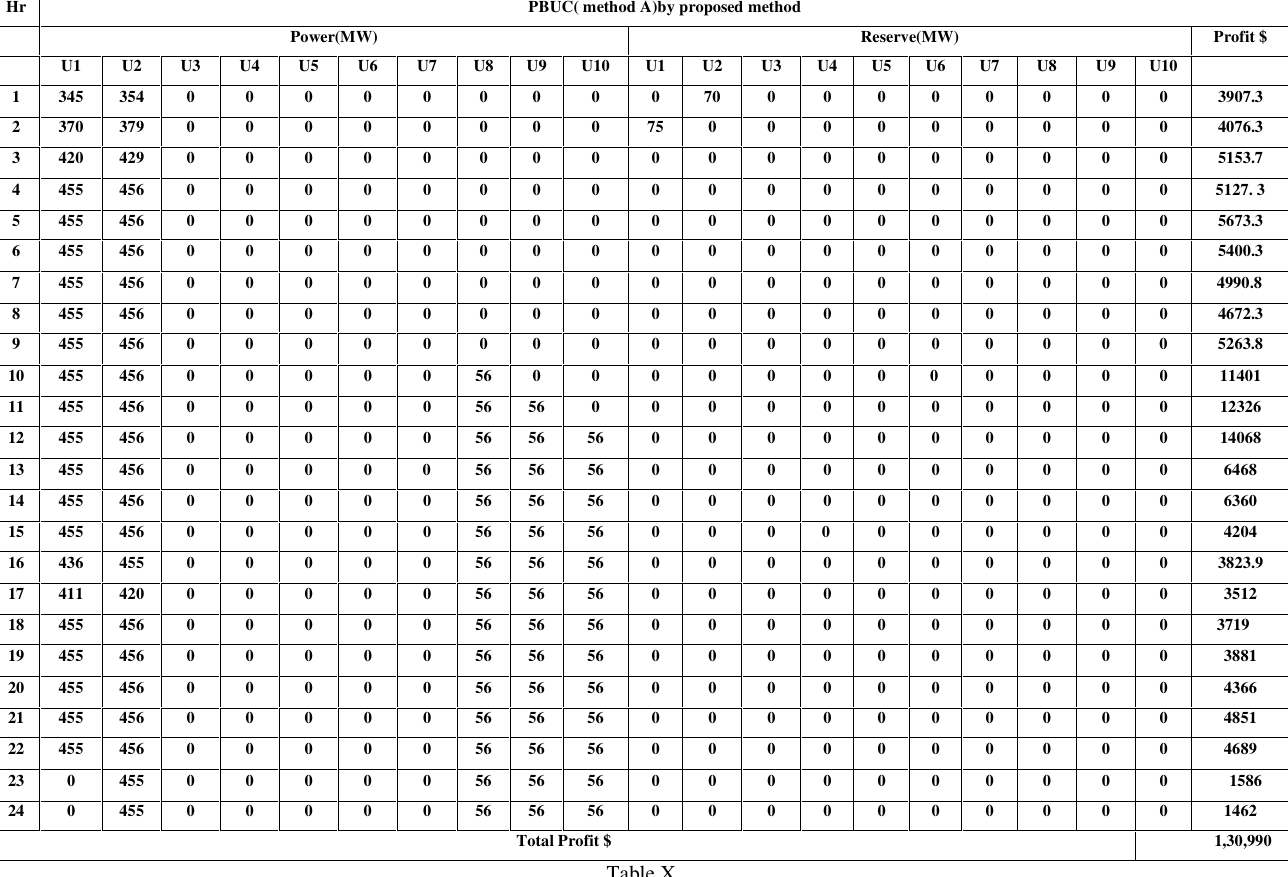
Table IX Example of power and Reserve generation of reserve payment method A (10 Units system)